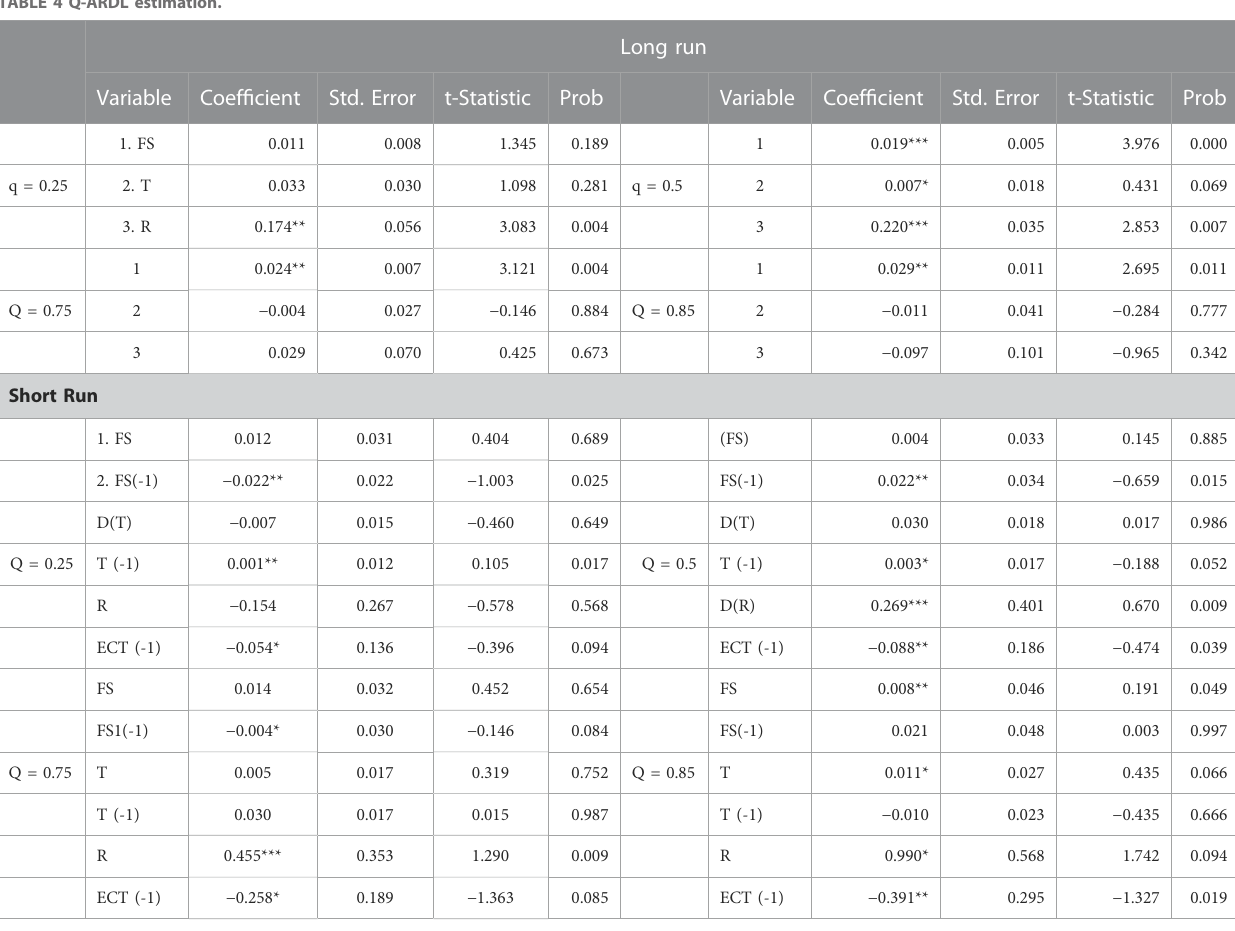
TABLE 4 Q-ARDL estimation.